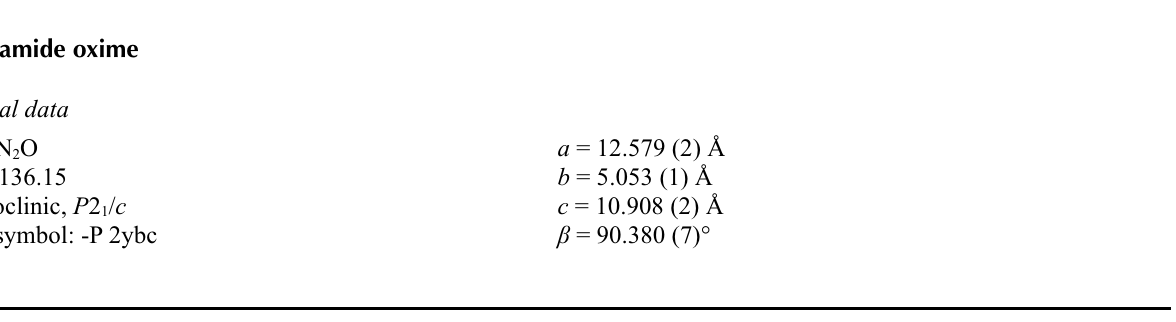
Figure 2 Part of the crystal structure showing hydrogen bonds as dashed lines. H atoms, except for those involved in hydrogen bonds, are not